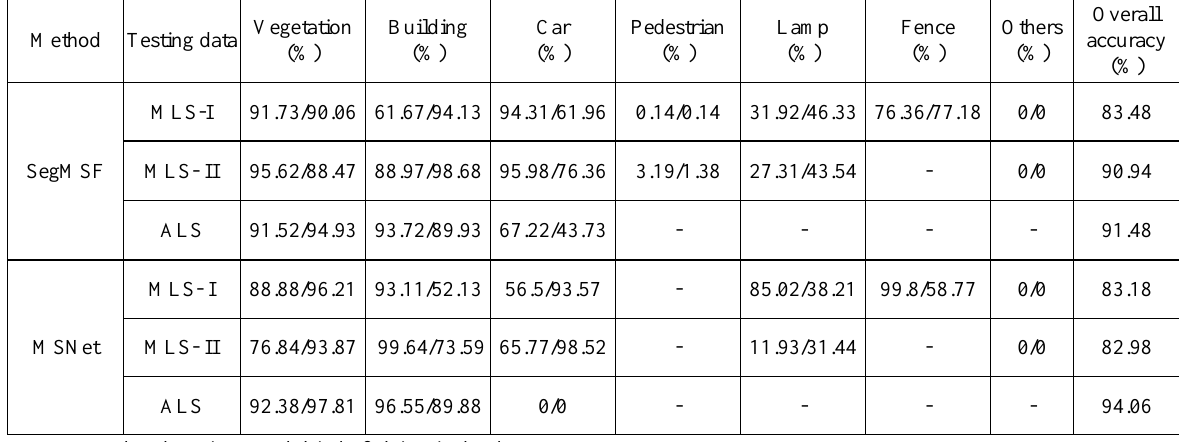
Table 2. The precision/recall and overall accuracy of the test data with the proposed method and MSNet.